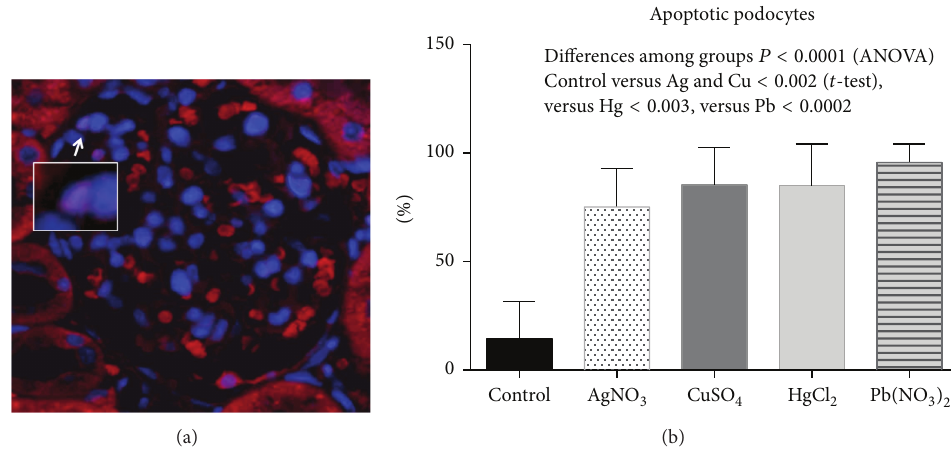
Figure 10: (a) Glomerulus showing podocytes tagged by WT1 in pink (arrow): the square corresponds to a magnified podocyte, nuclei stained in blue by DAPI. On (b) a graph showing the percent of apoptotic podocytes by metallic